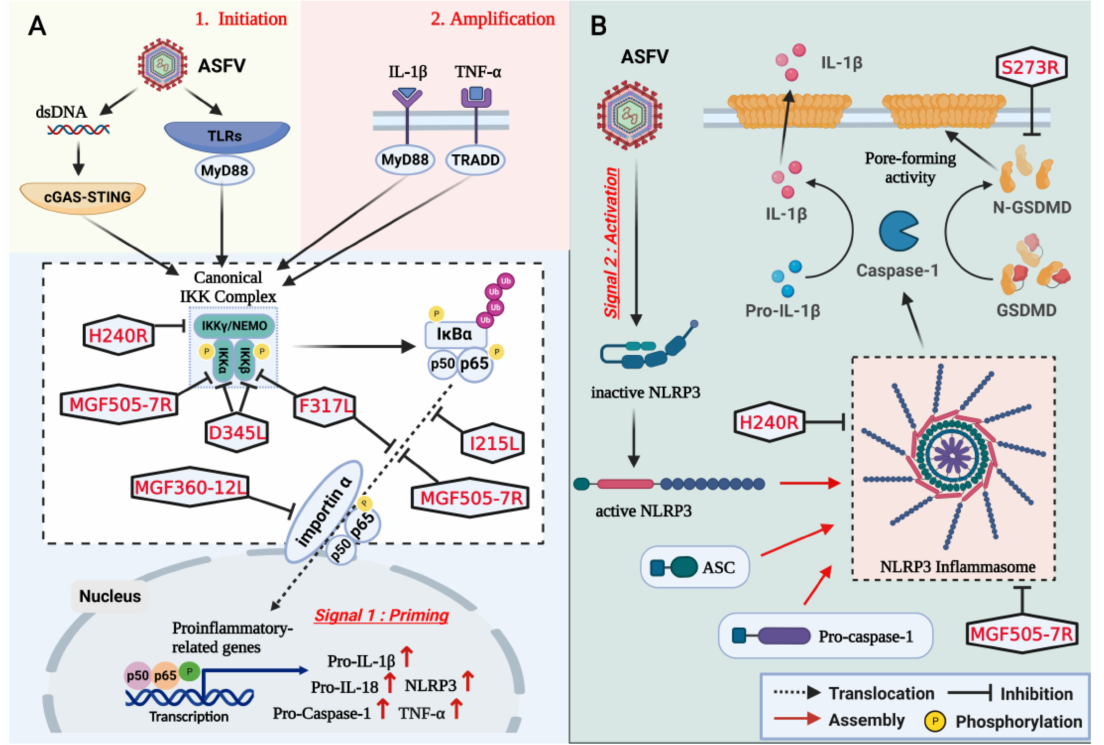
Figure 2. Schematic overview of inhibition of NLRP3 inflammasome activation and GSDMD- mediated pyroptosis by ASFV proteins in the latest reports. ( A ) ASFV pF317L, pH240R, pMGF505-7R, pD345L, pI215L, and pMGF360-12L inhibit the transcription of proinflammatory genes by targeting canonical NF- κ B pathway. Mechanistically, pF317L inhibits the phosphorylation of IKK β and the nuclear translocation of NF- κ B, pH240R mediates the degradation of NEMO, pMGF505-7R and pI215L inhibit the nuclear translocation of NF- κ B, pD345L directly interacts with IKK α and IKK β , and pMGF360-12L competitively inhibits the interaction between p65 and importin- α . ( B ) ASFV pH240R and pMGF505-7R inhibit the assembly of inflammasome, and pS273R inhibits the GSDMD- mediated pyroptosis. Mechanistically, pH240R suppresses NLRP3 oligomerization, pMGF505-7R directly interacts with NLRP3, and S273R cleaves N-terminal of